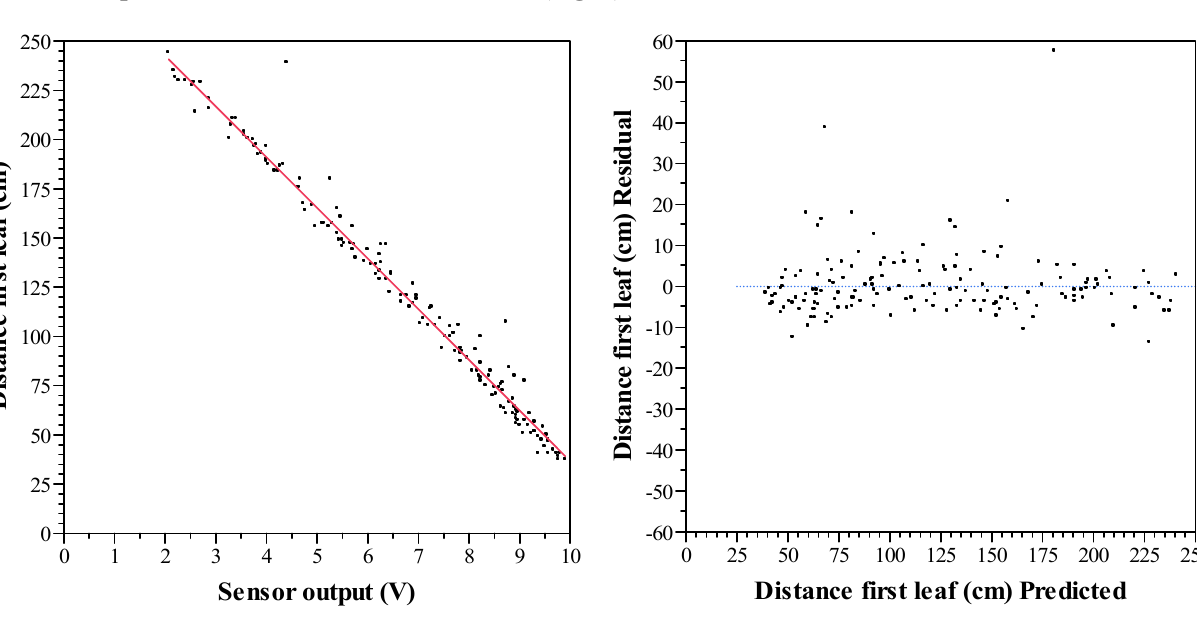
Figure 8. Scatter diagram of sensor output and distances to the first leaf ( left ) and residuals of the predicted distances to the first leaf ( right ) for the field distance measurement